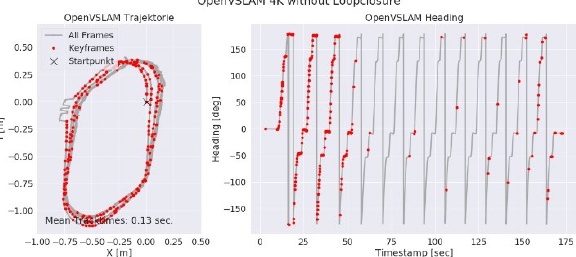
Figure 9. Horizontal drift: OpenVSLAM trajectory without loop closure for 13 laps (left) and evolvement of the horizontal drift (right)